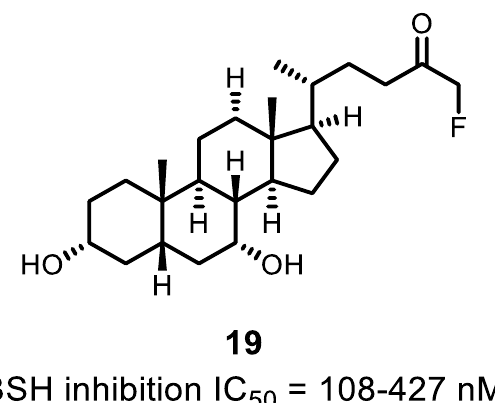
FIGURE 12: Structure and activity of the covalent pan-inhibitor of